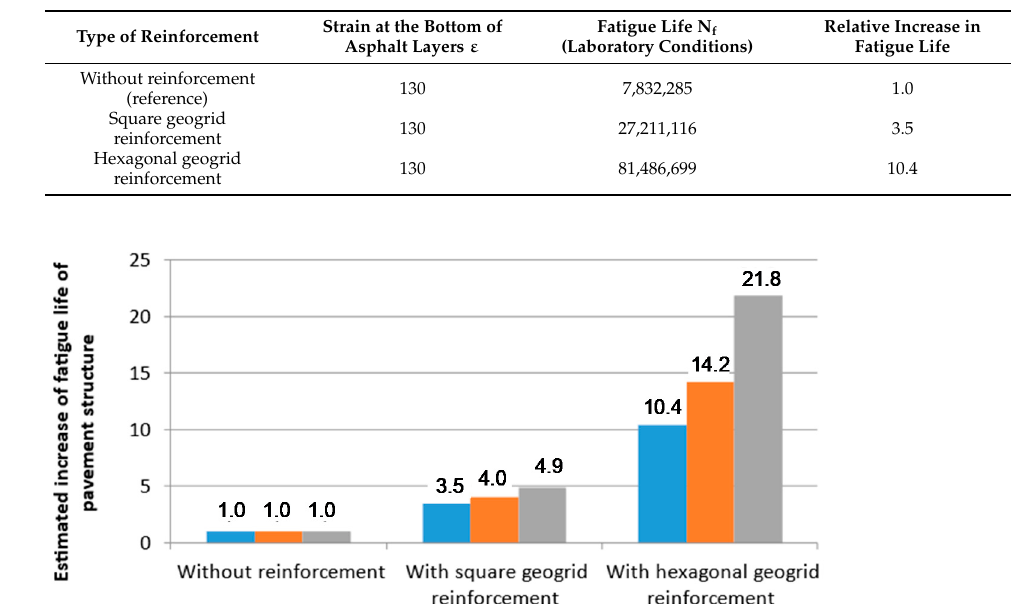
Table 5. Comparison of the calculated fatigue life of pavements without reinforcement, as well as reinforced with square and hexagonal geogrid composites.